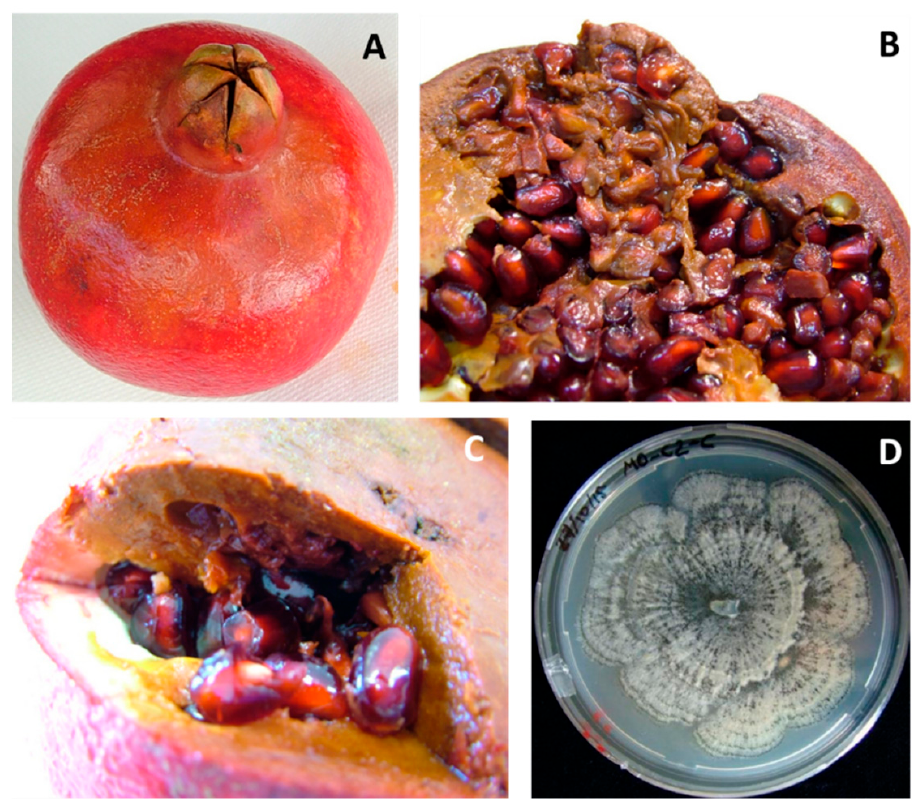
Figure 7. Coniella granati rot. ( A ) External symptoms. ( B ) View of internal decay. ( C ) Close ‐ up of the soft rot. ( D ) Colony on PDA plate.